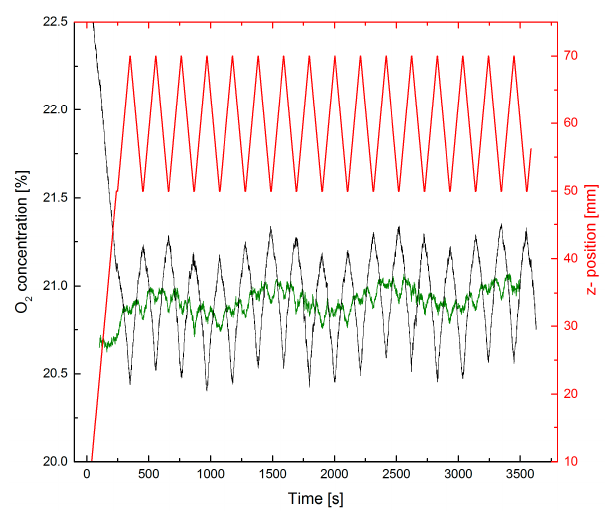
Figure 6. Distance variations during standoff O 2 measurements in ambient air using the leak plate as diffuse reflector. The leak plate was moved back and forth towards laser and detector for ± 1 cm (red curve, right ordinate scale). The resulting change of the O 2 concentration assuming a constant optical distance of 114 cm (laser-plate-detector) is shown. The green curve results from a later correction of the concentration measurement by the factor 114 cm/actual distance.